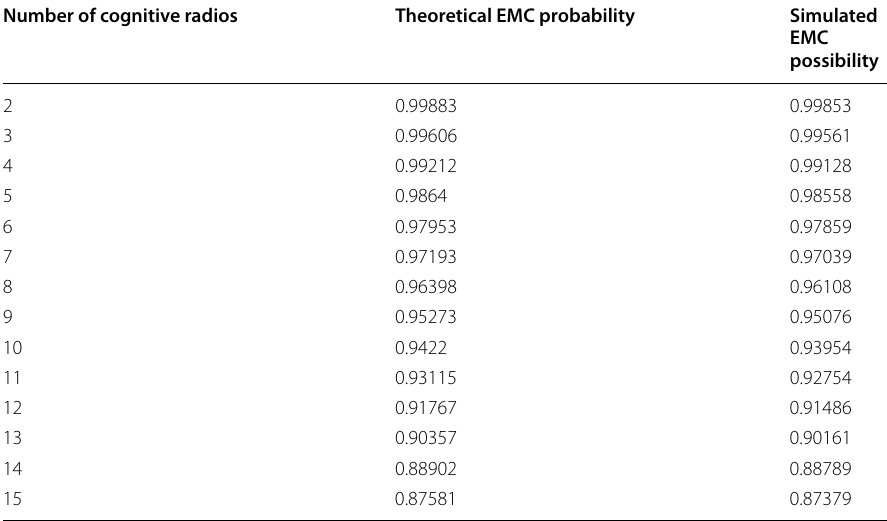
Table 3 Contrast between theoretical and simulated EMC results Number of cognitive